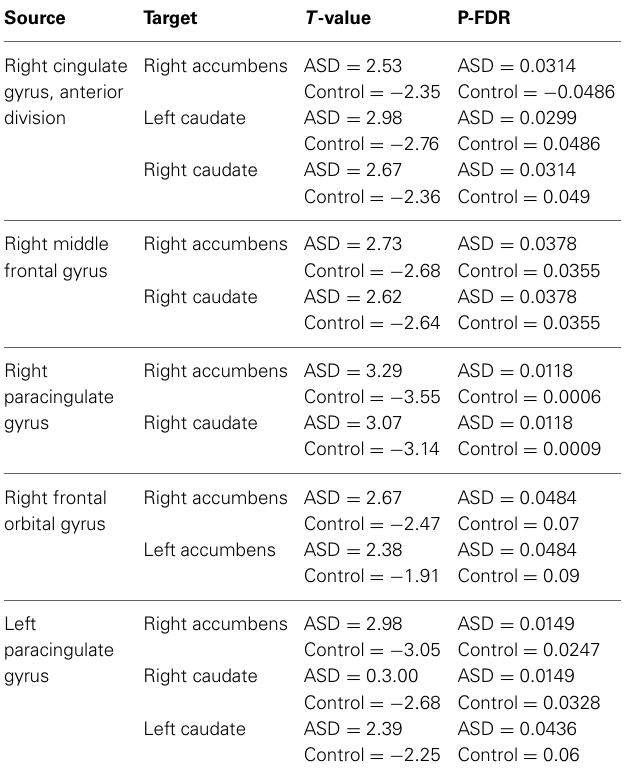
Table 3 | Within-groups t-scores and p-values for regions showing group differences in functional connectivity controlling for age, IQ and frame-wise displacements.